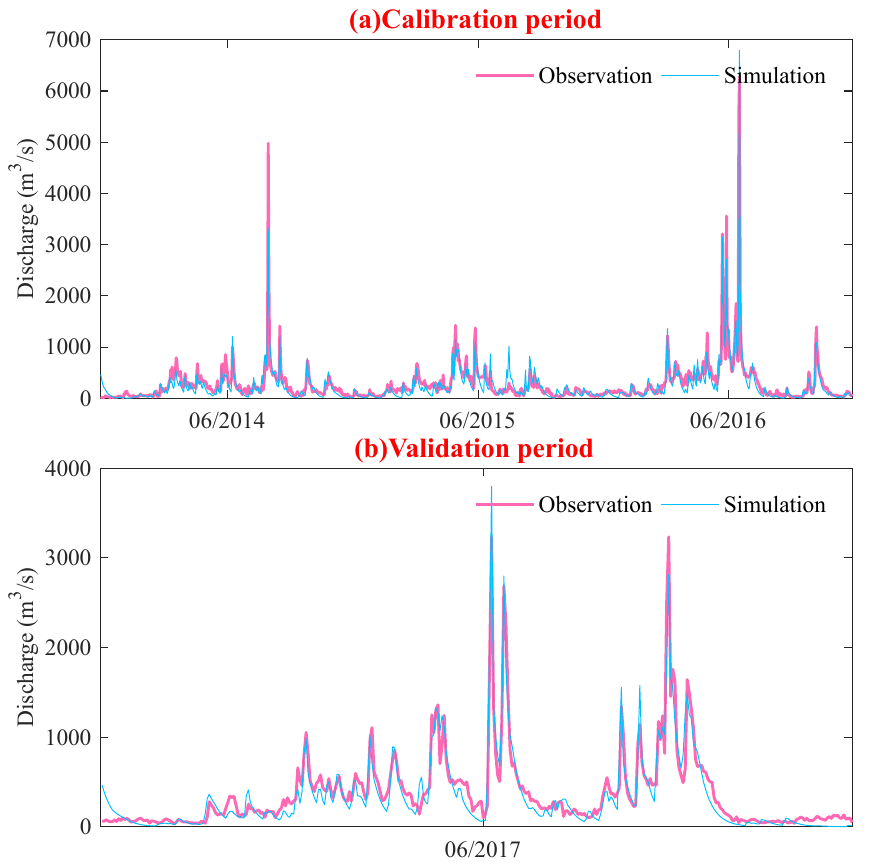
Figure 7. Hydrographs simulated by XAJ model in calibration and validation periods, compared with daily observations.